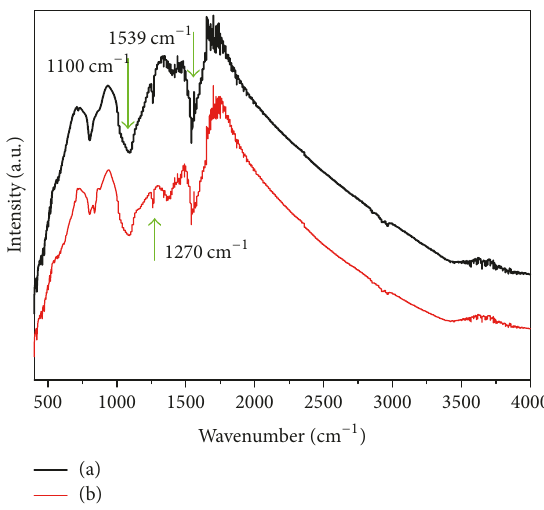
FFCA yield = moles of FFCA/moles of starting HMF × 100%.